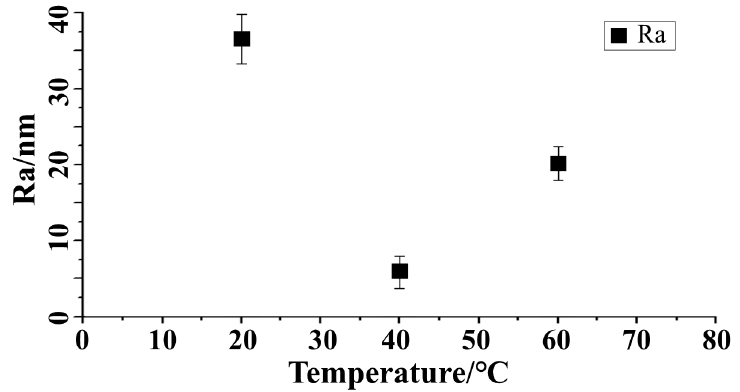
Figure 6. The relationship between Ra and electroplating solution temperatures with the pulse frequency fixed at 200 Hz.